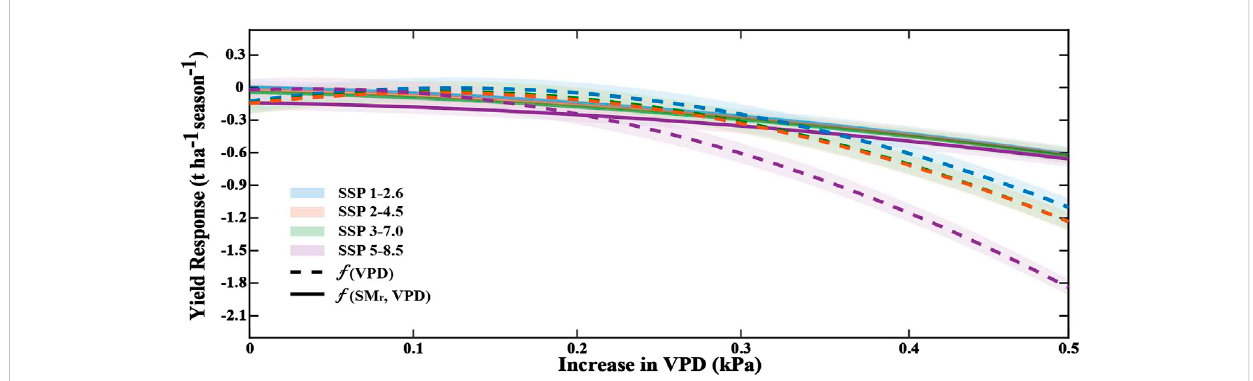
FIGURE 7 MaizeyieldresponsetoVPDandSM r indifferentSSPs.IncreasingtheobservedVPDandusingthe fi ttedpolynomialfunctionoftheVPD(dashedline) and the fi tted polynomial function of VPD and SM r (active line) to predict the future response of maize yield to VPD elevation in China. The shaded con fi dence interval represents asigni fi cant coef fi cient of fi t ( p < 0.05) from the distributionof the mean yield estimated from thebootstrap data from the grid ( n =